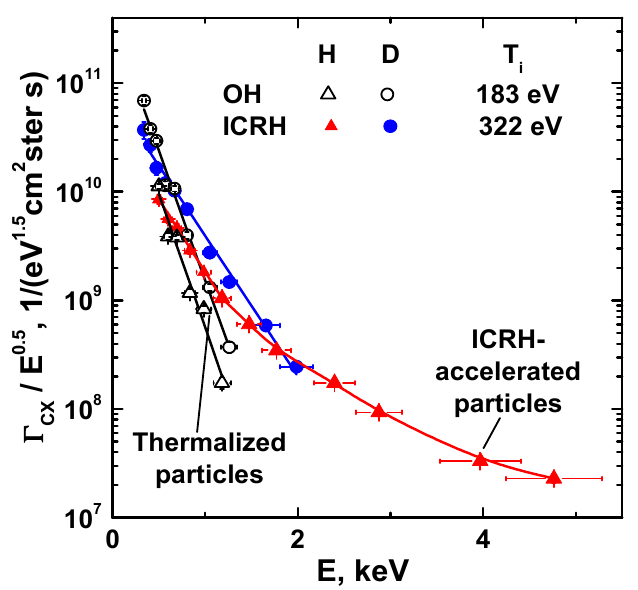
Figure 7. Spectra of CX, H, and D atoms obtained using the ACORD-12 analyzer, which detects “transverse” particles in Ohmic discharge and during ICRH (discharges ##11360–11363). The